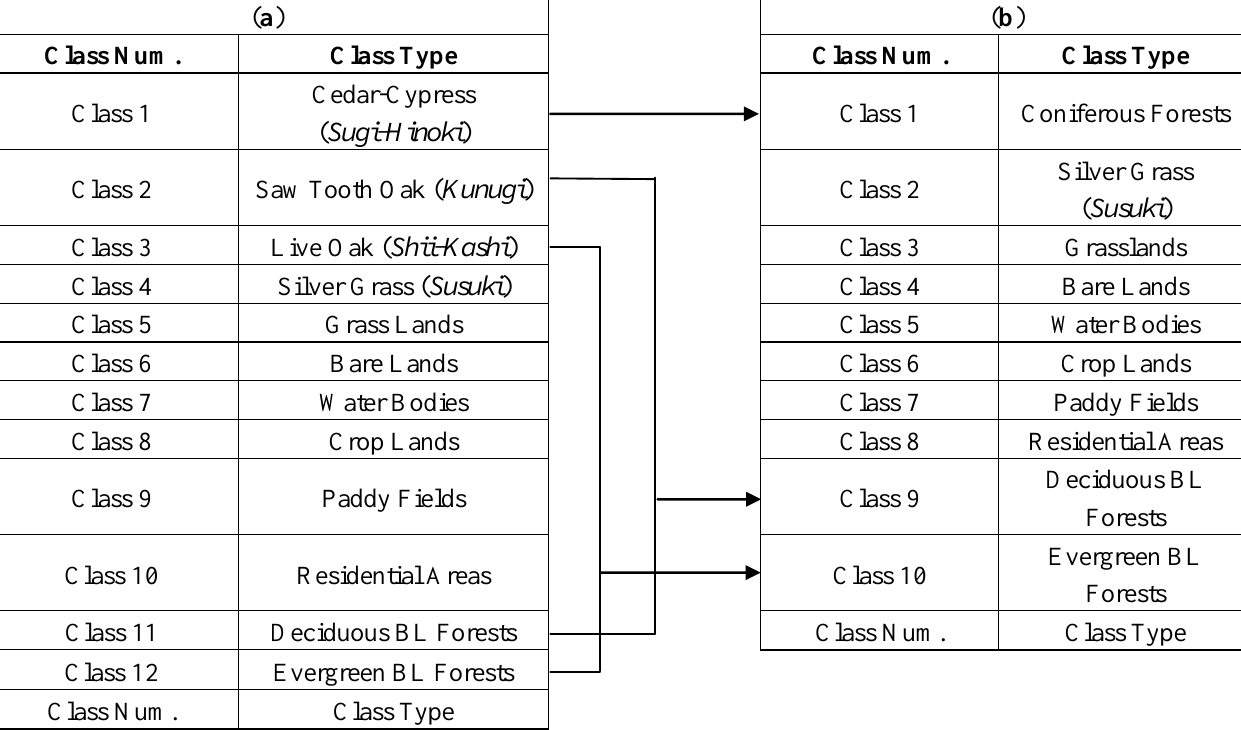
Table 2. Land cover classes: ( a ) Original outputs; ( b ) The final product. Class Num.